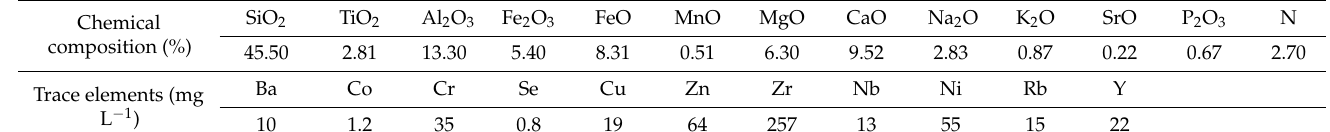
Table 3. Chemical composition of n-ZEs after being loaded with nitrogen.